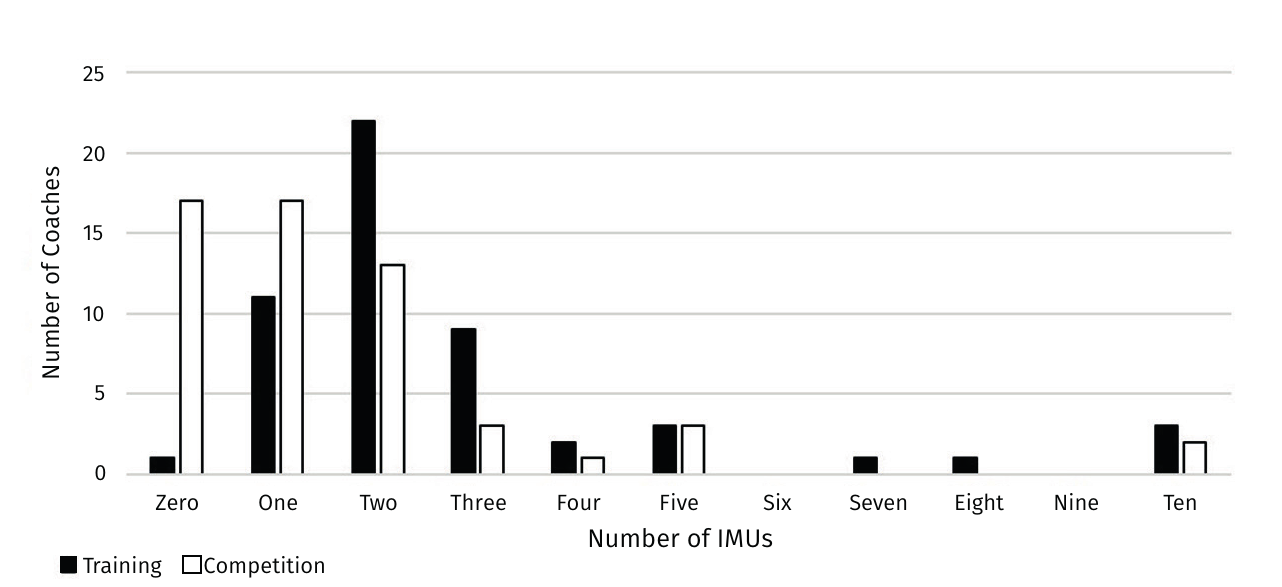
Figure 1. Maximum Number of IMUs Supported for Use During Training and Competition (Excluding Outliers Above 10